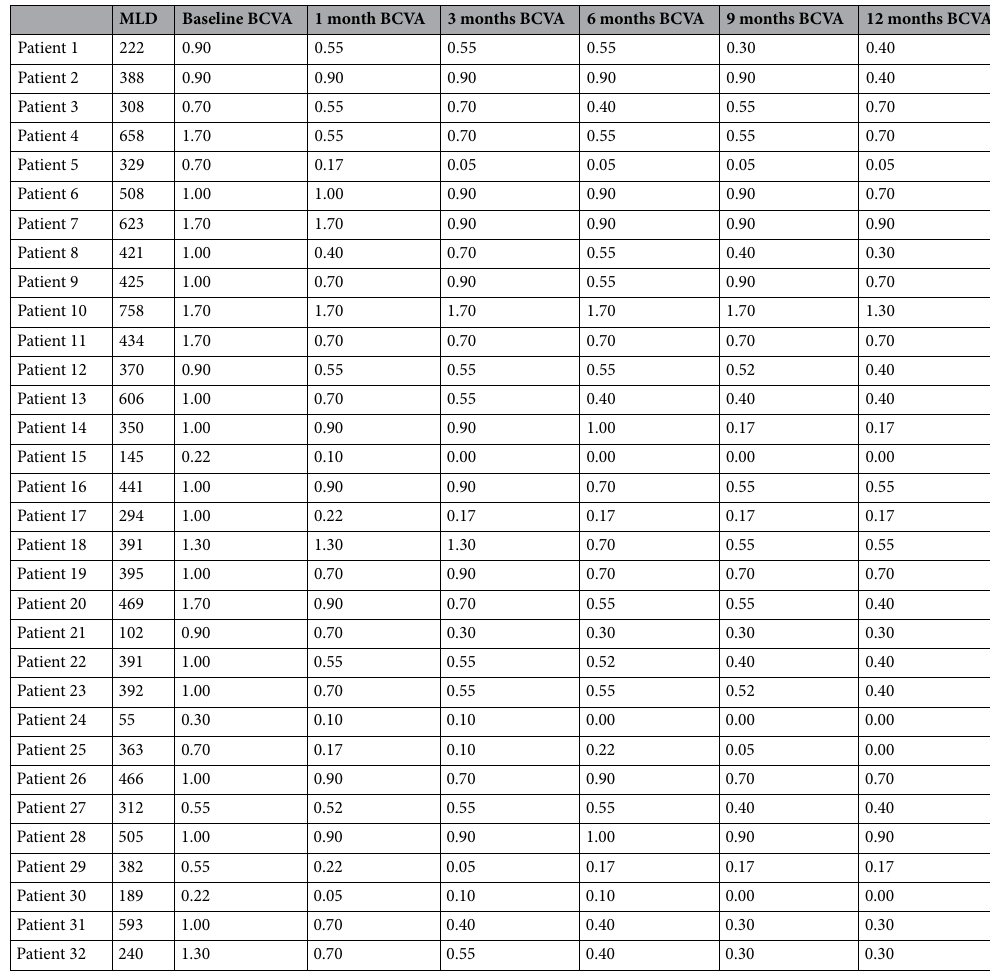
Table 2. The minimum linear diameter of macular hole and visual acuity for each patient. MLD minimum linear diameter, BCVA best-corrected visual acuity.